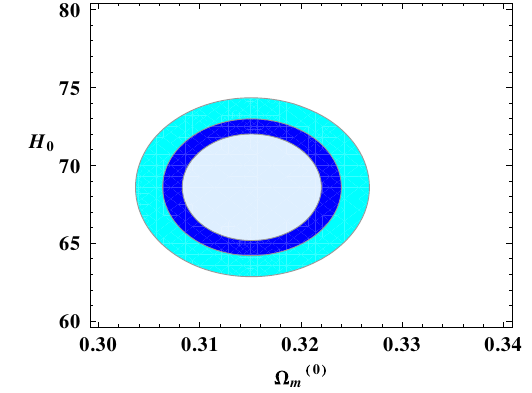
Fig. 7 Observational constraints on the parameters space ( (cid:13) ( 0 ) m − H 0 ) at the 68.3% (light blue), 90% (dark blue) and 99% (cyan) confidence levels